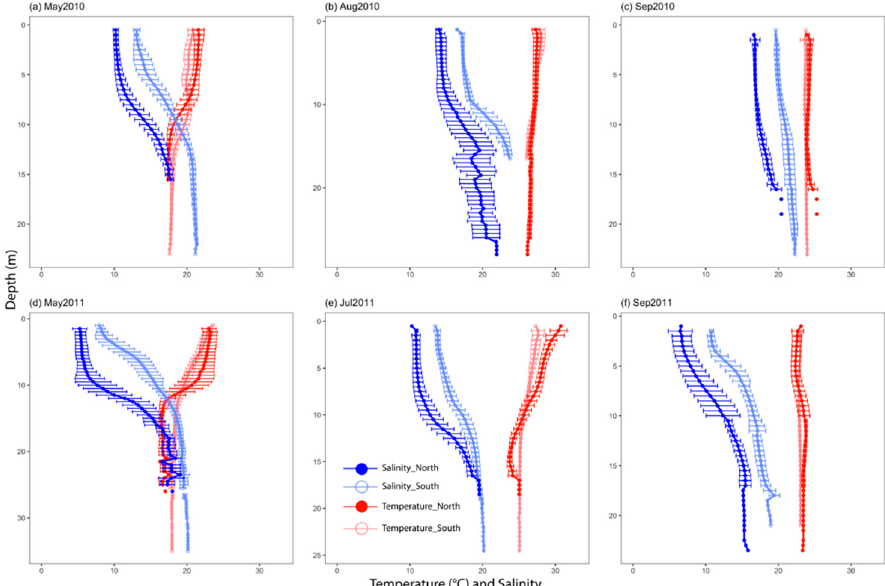
Figure 2. Average temperature ( ° C, red) and salinity (blue) from the CTD casts taken at North (closed) and South (open) stations during 2010 ( a – c ) and 2011 ( d – f ) cruises. Symbols represent mean values in 0.5-m bins from all CTD measurements at each depth, and horizontal lines indicated standard deviations. Modified from [64].